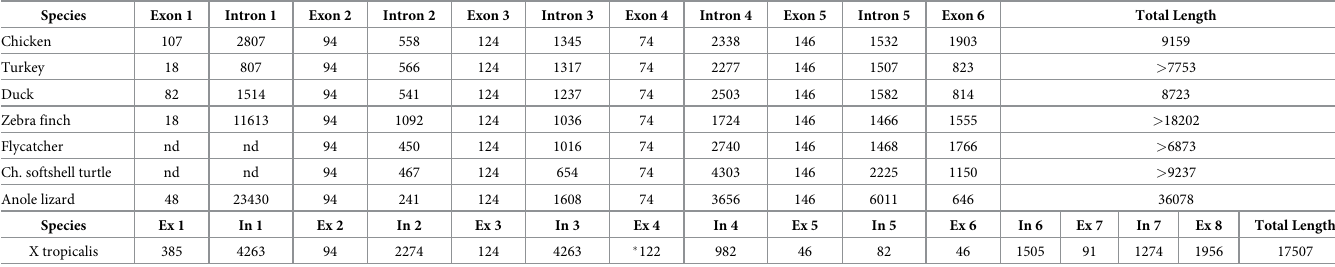
Table 2. Characterization of terrestrial vertebrate Zmat2 genes (in base